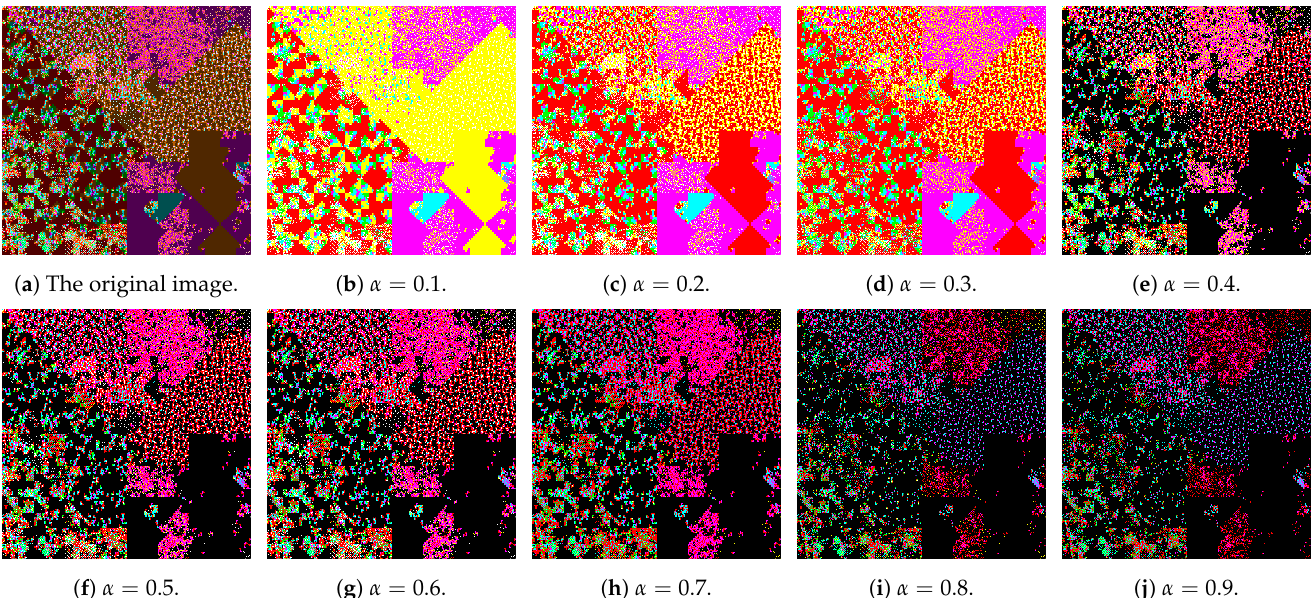
Figure 6. A malicious image in ( a ) and reduced images of it, for α = [ 0.1, . . . ,0.9 ] in ( b – j ), respectively.